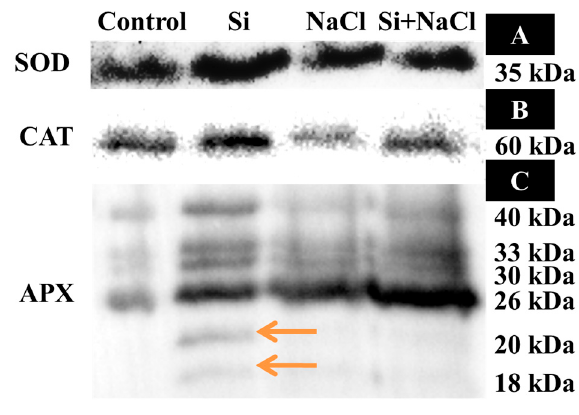
Figure 6. Immunoblotting analysis of superoxide dismutase (SOD) ( A ), catalase (CAT) ( B ), and ascorbate peroxidase (APX) ( C ). Differentially-expressed isomers of APX are denoted with orange arrows.